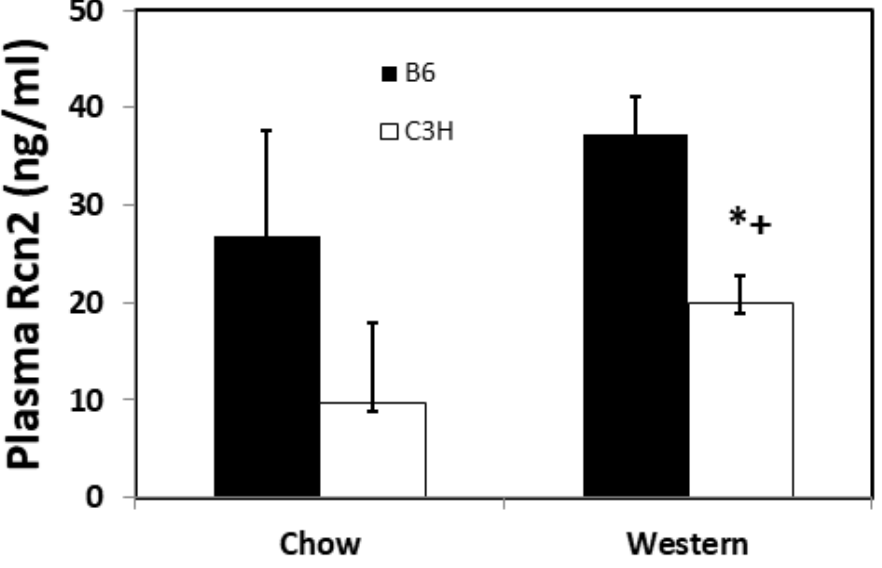
Figure 3. Plasma Rcn2 protein levels (ng/mL) of female B6 and C3H Apoe − / − mice fed a chow or Western diet. Results are means ± SD of 4 mice per strain. * p < 0.05 versus B6 mice fed the same diet, and + p < 0.05 versus the same mouse strain fed the chow diet. Two-way ANOVA was performed to